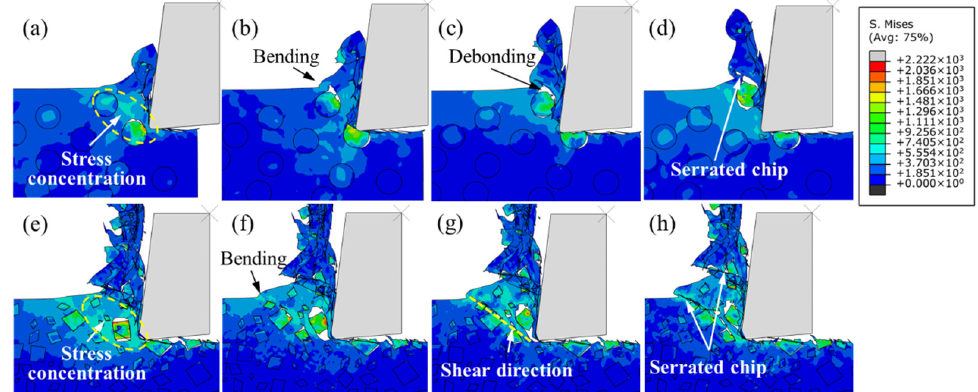
Figure 11. Mises stress distribution during chip formation: ( a – d ) circular particles; ( e – h ) irregular polygonal particles.